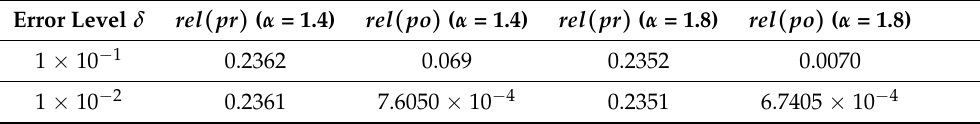
Table 1. The relative error of Example 1.